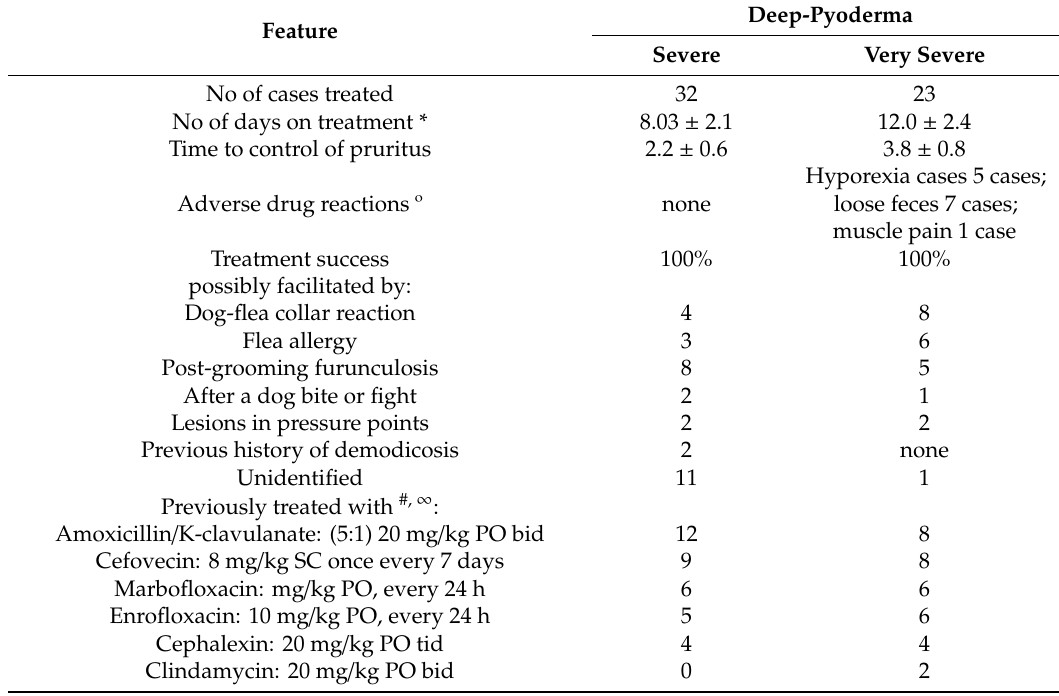
Table 3. Summary of treatment outcomes of 55 cases of deep-canine pyoderma, unresponsive to initial antibacterial treatment, and treated orally with enrofloxacin HCl-2H 2 O (enro-C) at a dose of 10 mg/kg once a day and enro-C as gel, topically applied on affected areas, thrice a day.